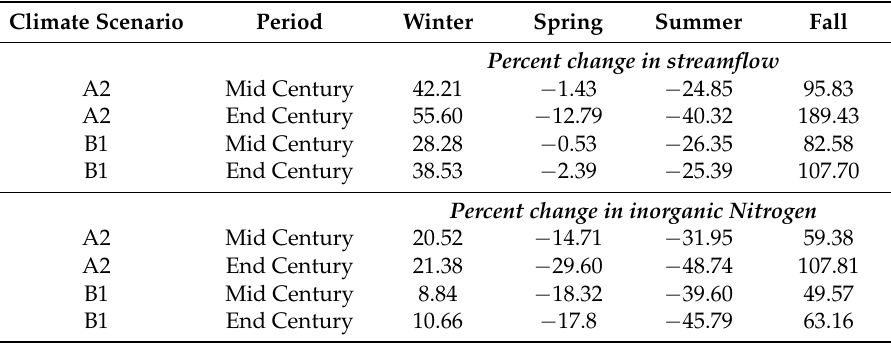
Table 4. Seasonal percent changes in streamflow and inorganic nitrogen loading by mid-century (2048–2065) and end-century (2085–2099) from the base period for different emission scenarios. Values refer to the change from baseline period